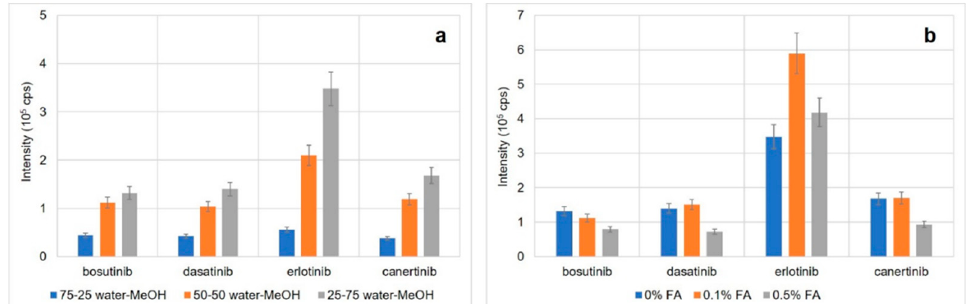
Figure 2. Optimization of the sheath liquid composition. ( a ) Optimization of water–methanol ratio, ( b ) effect of formic acid content; error bars represent SD values (n = 3). Table 1. SRM transitions of model TKIs.